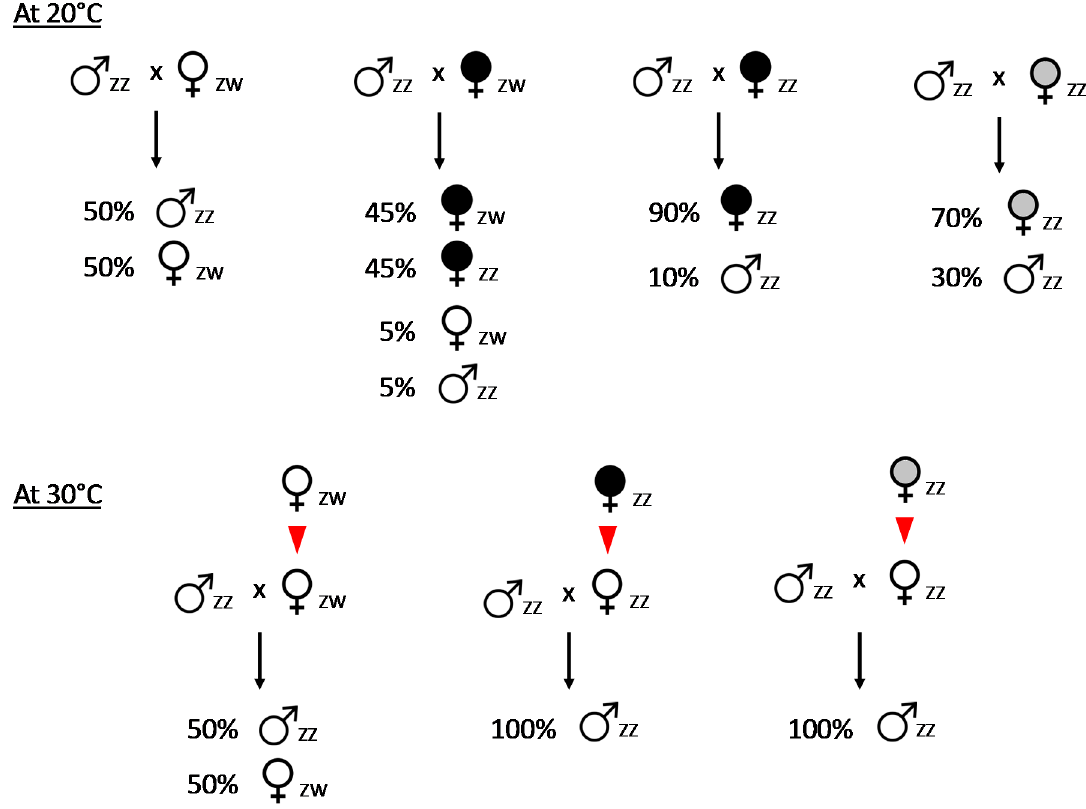
Figure 2. Crosses involving Armadillidium vulgare individuals carrying Wolbachia (black), the f element (grey) or none (white), at 20 °C (top) and 30 °C (bottom). ZZ/ZW: the homo/heterogametic status of individuals. Red triangles denote the elimination of the thermosensitive Wolbachia and the f element from mothers at 30 °C. Wolbachia and f element transmission rates from mother to offspring at 20 °C are assumed to be 90% and 70%, respectively. Wolbachia and f element elimination rates from mothers at 30 °C are assumed to be 100%, although some variation may occur depending on experimental conditions.